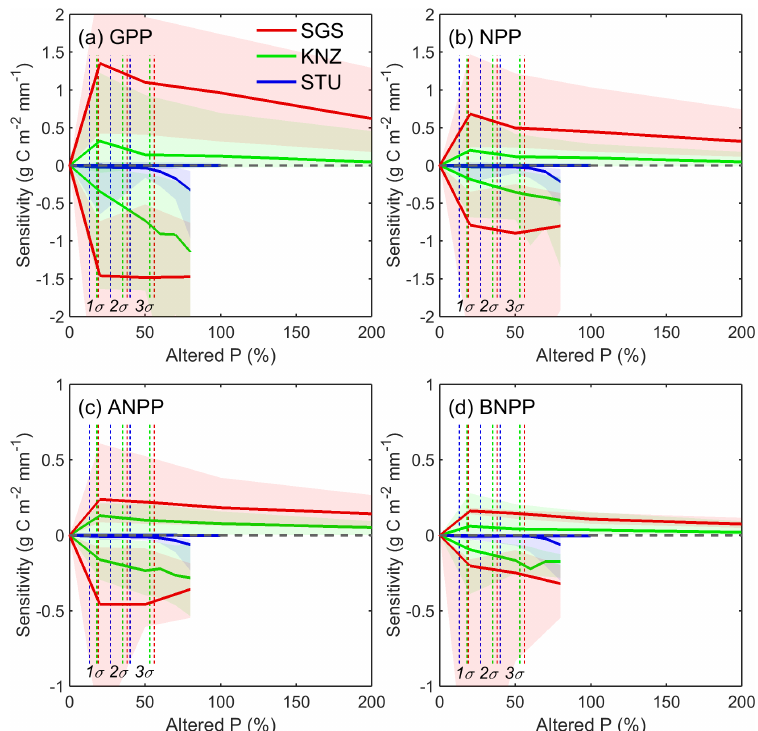
Figure 3. Sensitivity of GPP (a) , NPP (b) , ANPP (c) and BNPP (d) for altered precipitation simulations at the three sites SGS, KNZ and STU. Curves show the ensemble mean of models, and the shading represents the model uncertainty range using the interquartile spread of the sensitivities between individual simulations (10th and 90th percentiles). Curves above the zero line represent responses under increasing precipitation conditions relative to the control, and curves below the zero line show responses under decreasing precipitation conditions relative to the control. Vertical dashed lines represent precipitation variations of 1 standard deviation (1 σ ), 2 standard deviations (2 σ ) and 3 standard deviations (3 σ ), which were derived from long-term annual precipitation at the three sites